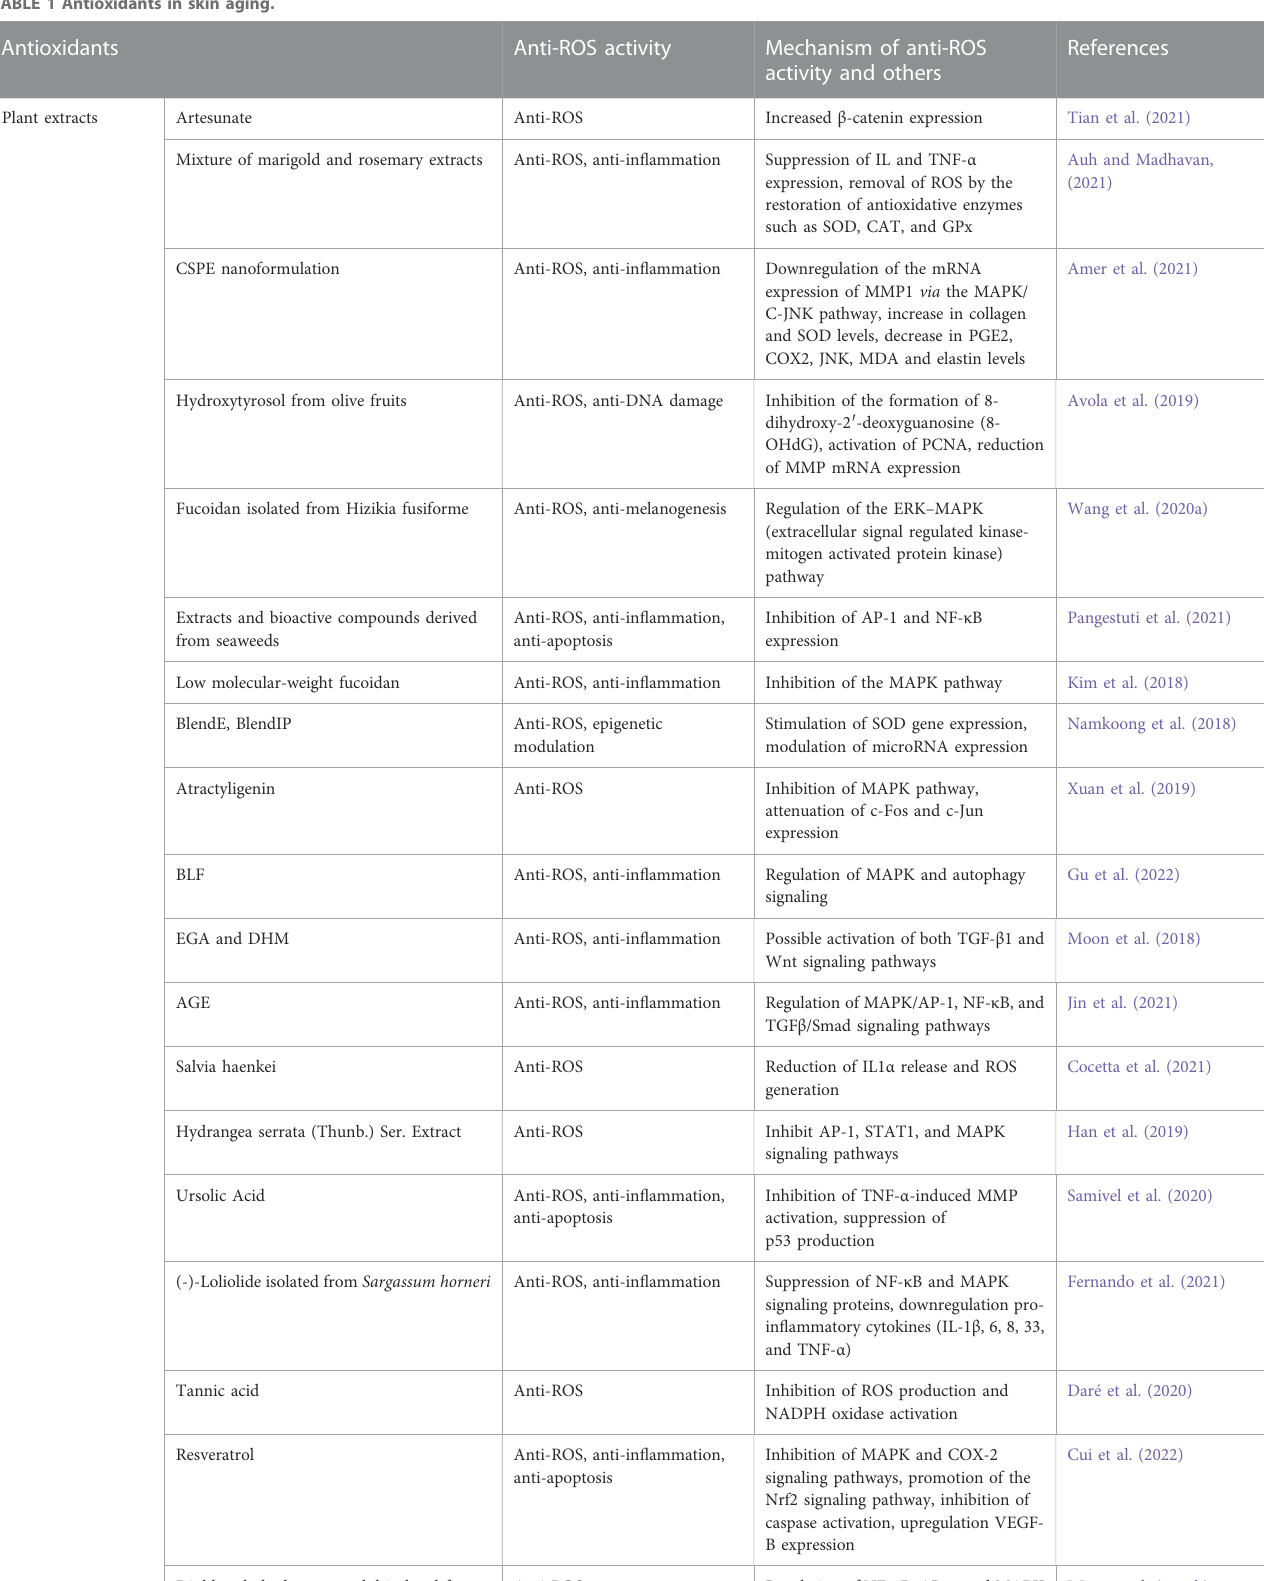
TABLE 1 Antioxidants in skin